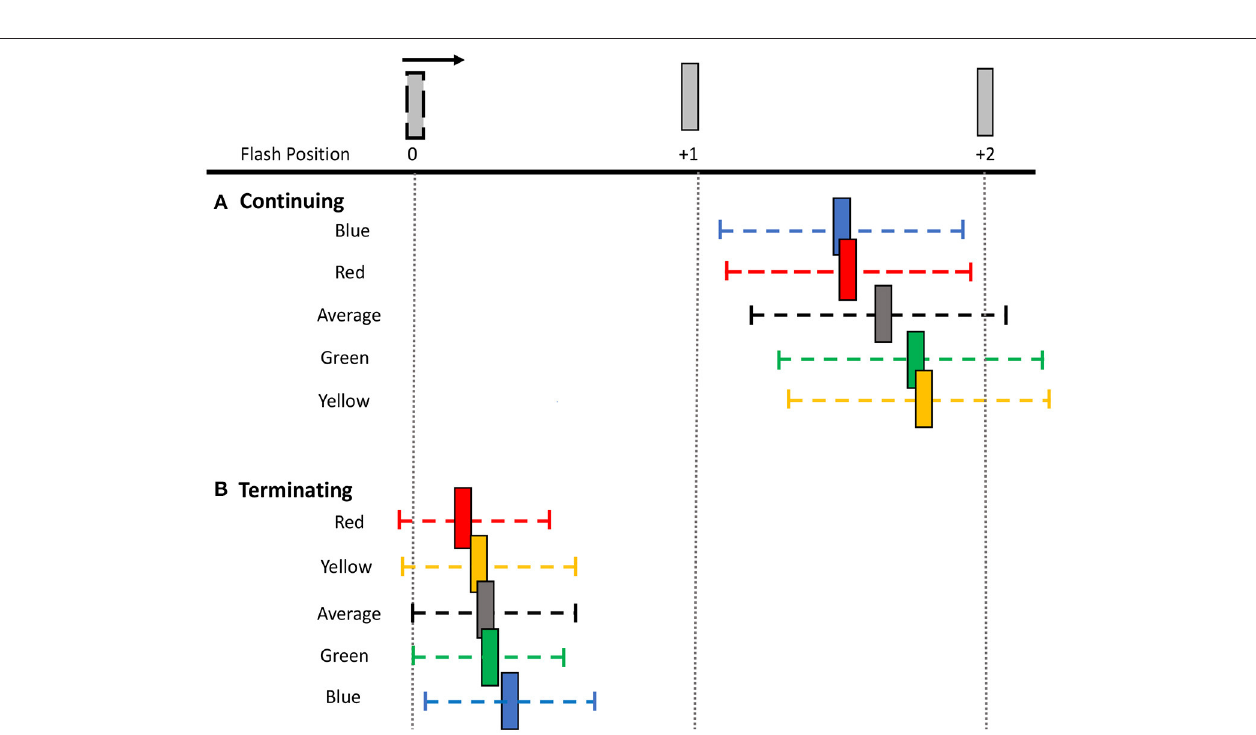
FIGURE 3 | Perceived shifts. The mean ± SEM shift (dva) in the perceived flash location for both terminating and continuing motion paths. Positive values correspond to a forward shift along the direction of motion. Corrected ** p < 0.01, *** p < 0.001.